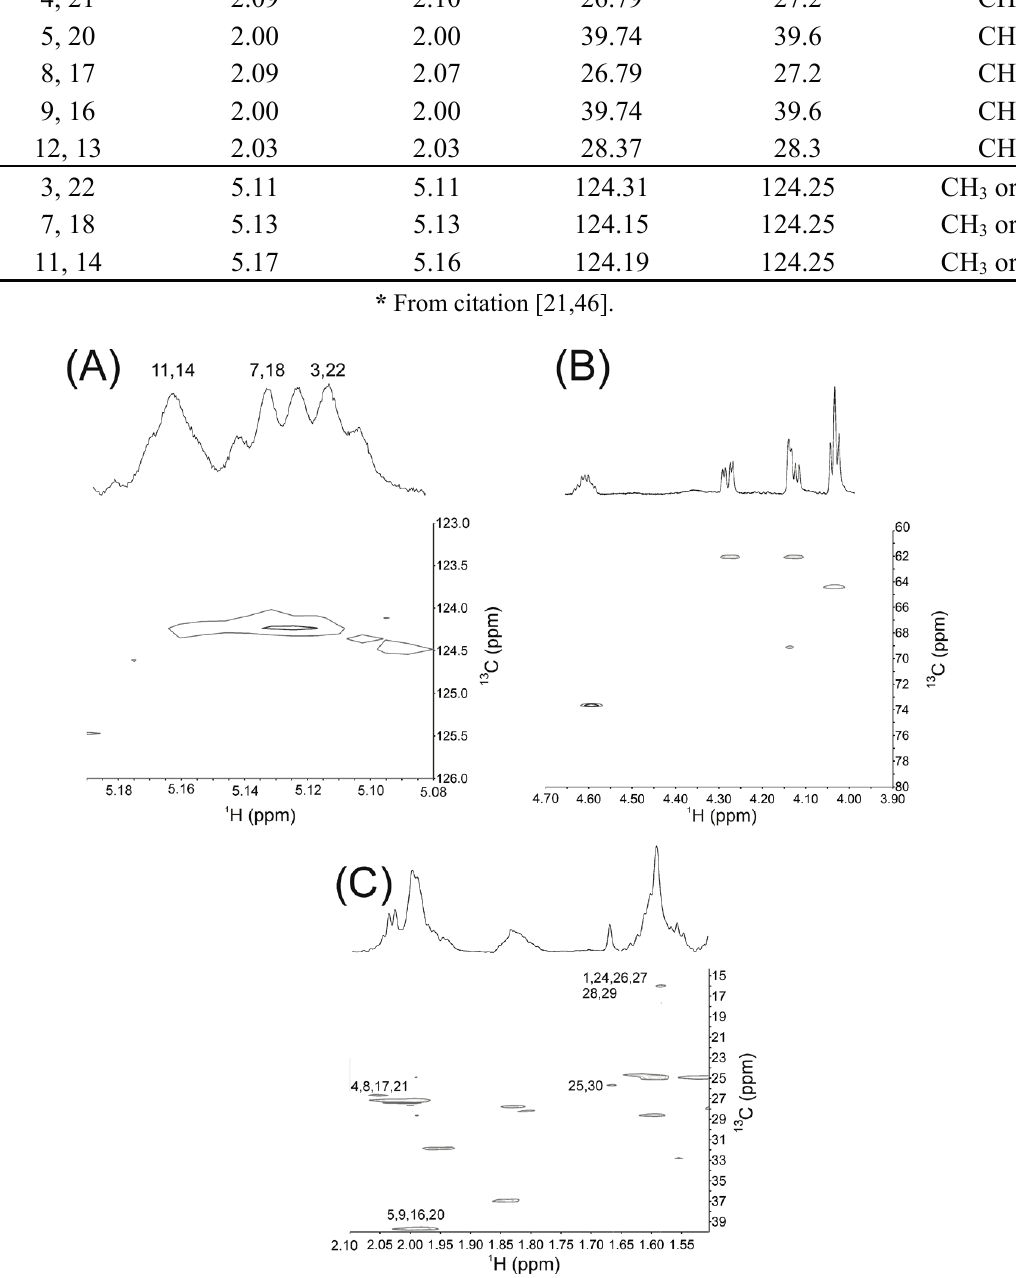
Figure 3. 1 H NMR spectra of tear lipid extracted from Shirmer’s strips atop the heteronuclear single quantum correlation (HSQC) spectra. Numbers correspond to the carbon numbers for SQ (Figure 1) assigned to the resonances. The chemical shifts are listed in Table 2. ( A ) CH resonance region; ( B ) Ester resonance region; and ( C ) CH 3 , CH 2 resononance